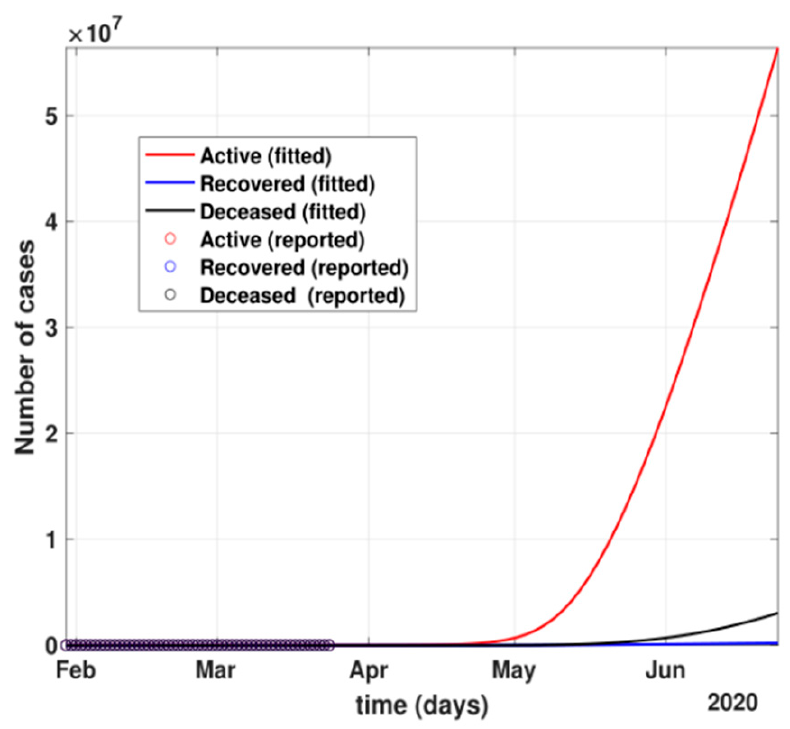
Figure 6. The prediction for active cases after 24 March 2020 with no government control or public health safety measures.